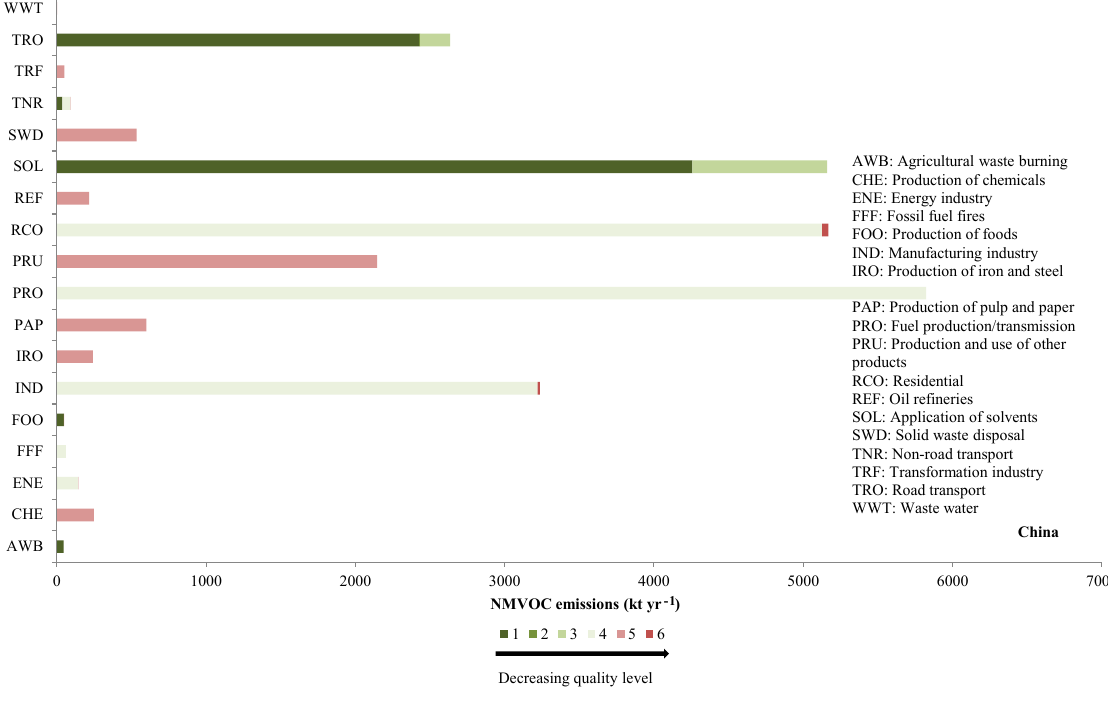
Figure 9. NMVOC emissions of different sources associated with each quality code in 2010 in China.